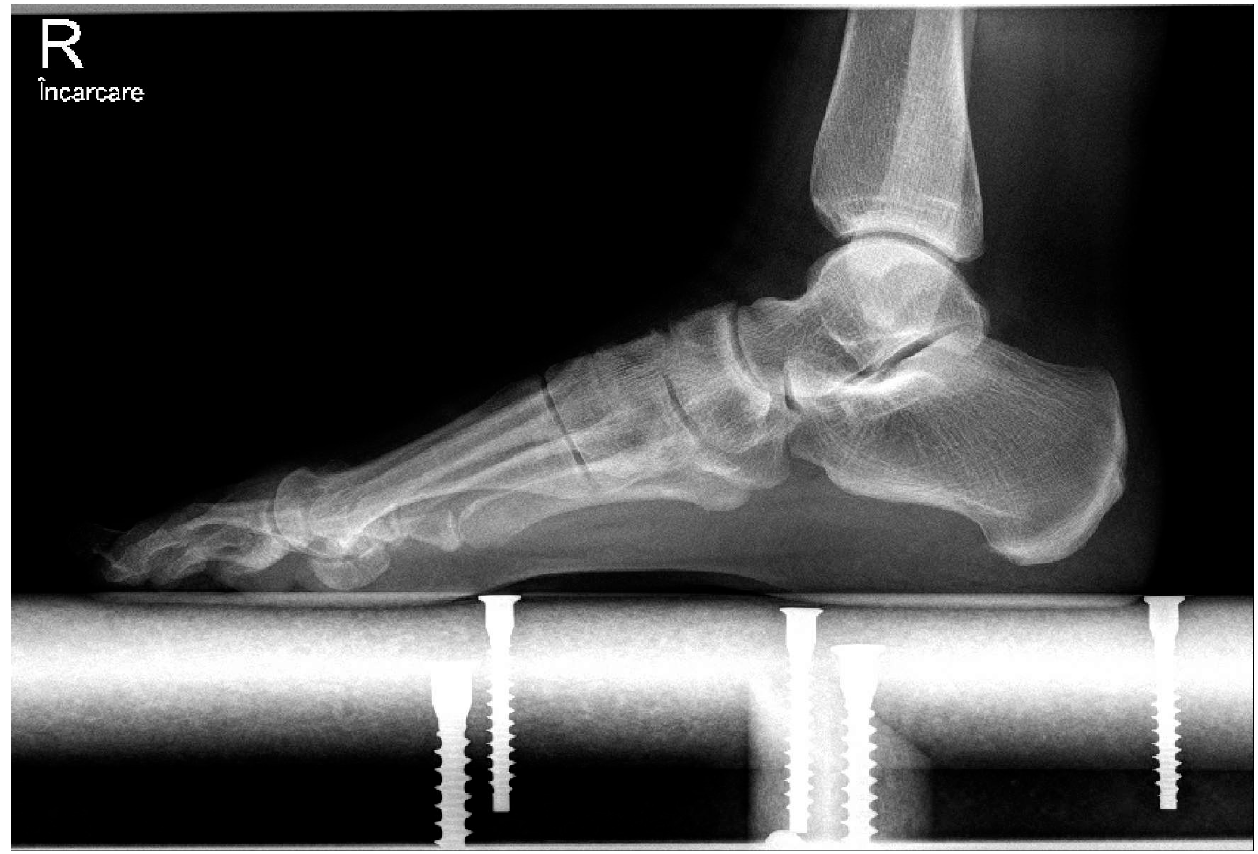
Figure 2. Preoperative lateral weight-bearing image.